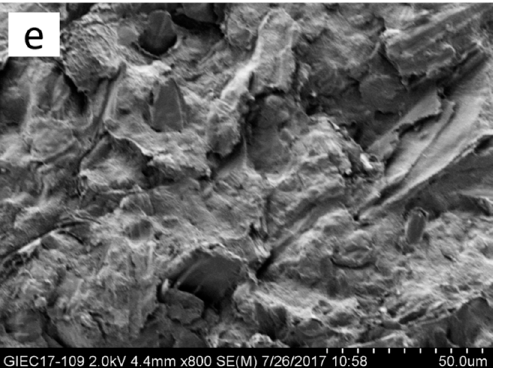
Figure 8. SEM images of interfacial adhesion with different MAPE contents: ( a ) 0%; ( b ) 3%; ( c ) 5%; ( d ) 7%; and ( e ) 9%.